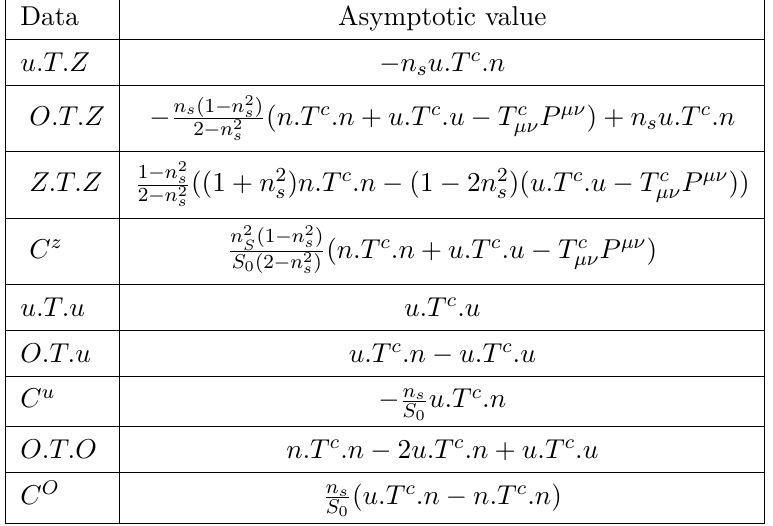
Table 1 . Asymptotic